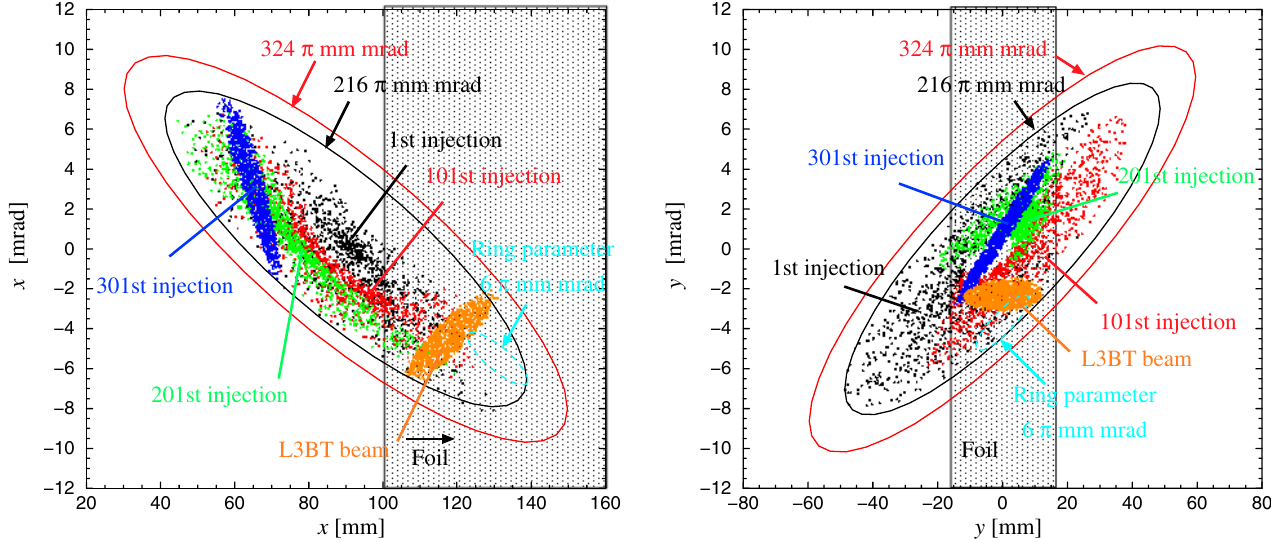
FIG. 10. (Color) Phase-space distribution with a limited painting area of the mismatched and deformed beam with the L3BT optics of (cid:2) 11 : 3 ; 8 : 9 (cid:3) (cid:1) mm mrad at the injection point ( s (cid:4) 82 : 113 m ) during 308 turns with the painting process. The 1st (black), 101st (red), 201st (green), and 301st (blue) injected bunches are traced.